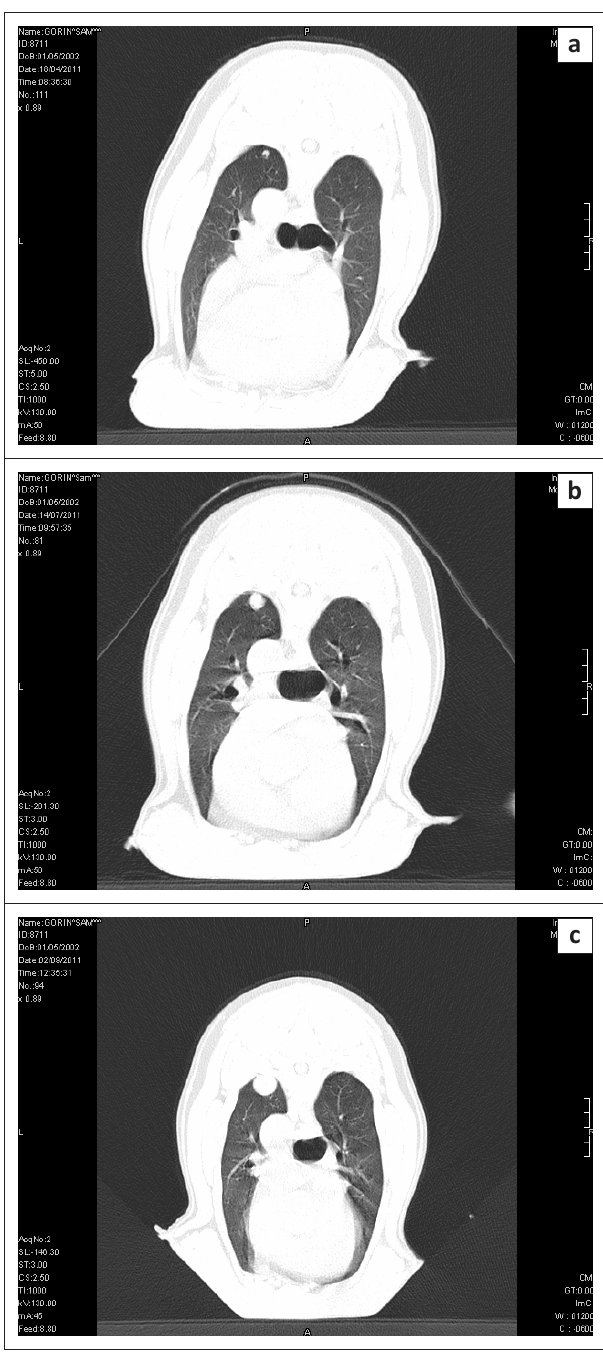
FIGURE 5: Computed tomography scan of the thorax, showing growth of the metastatic nodule in the left caudo-dorsal lung lobe at (a) one, (b) four and (c) seven months after